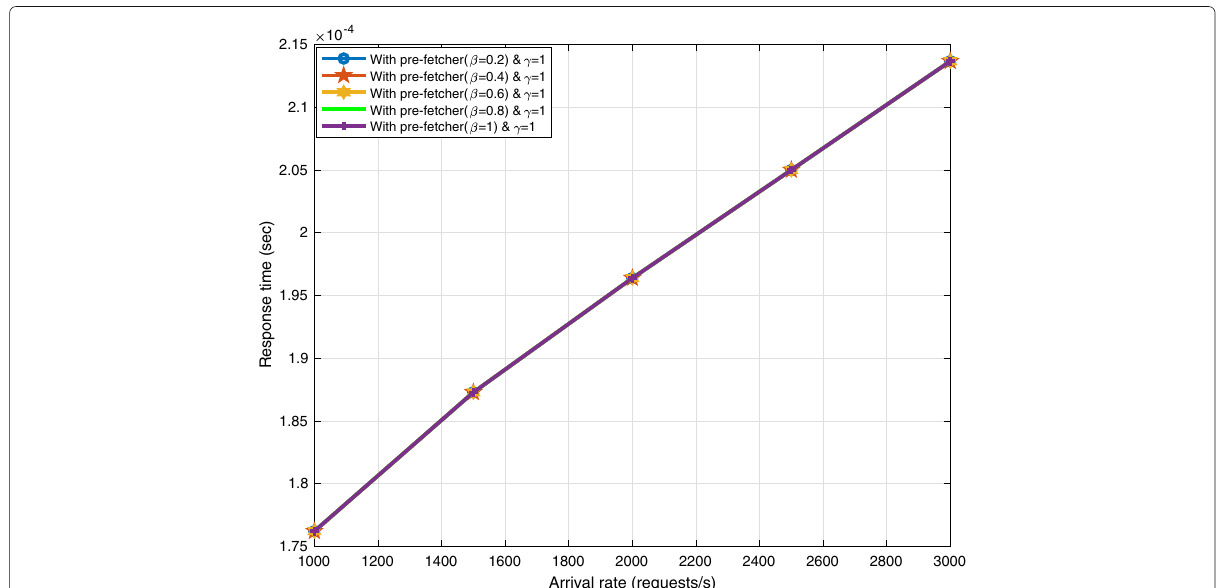
Fig. 5 Response time vs. arrival rate while the workload is shared between multimedia cloud and pre-fetcher at probability distribution of β . With pre-fetcher ( β = 0.2) and γ = 1, With pre-fetcher ( β = 0.4) and γ = 1, With pre-fetcher ( β = 0.6) and γ = 1, With pre-fetcher ( β = 0.8) and γ = 1, With pre-fetcher ( β = 1) and γ = 1,